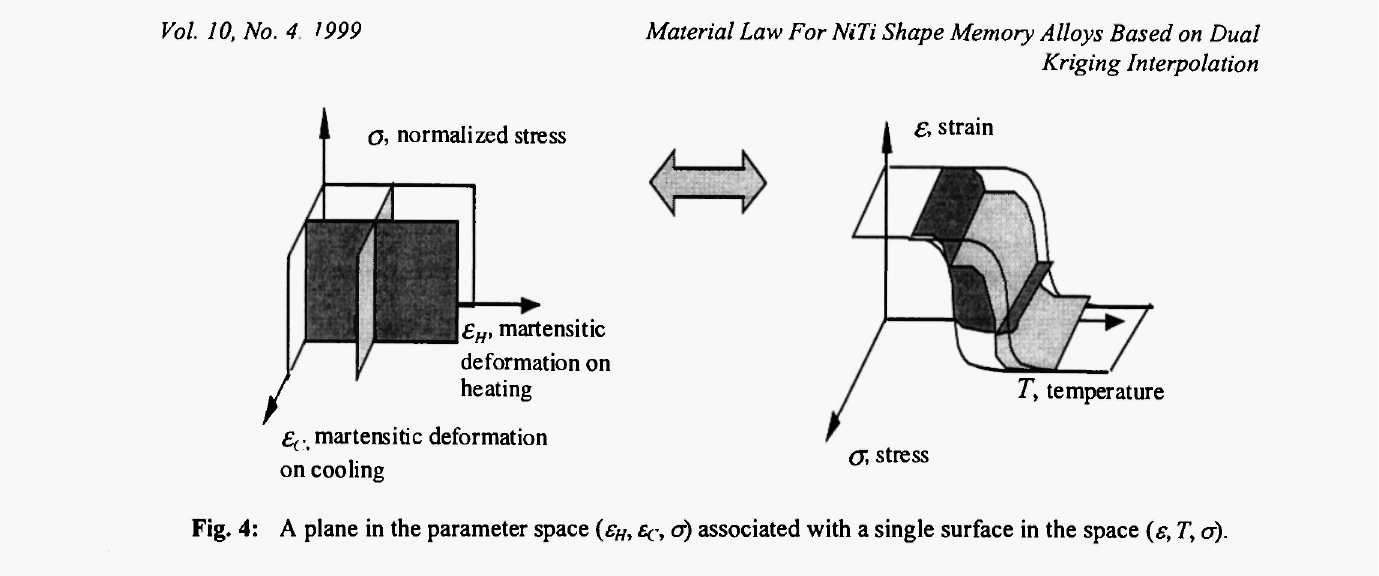
Fig. 4: A plane in the parameter space (ε